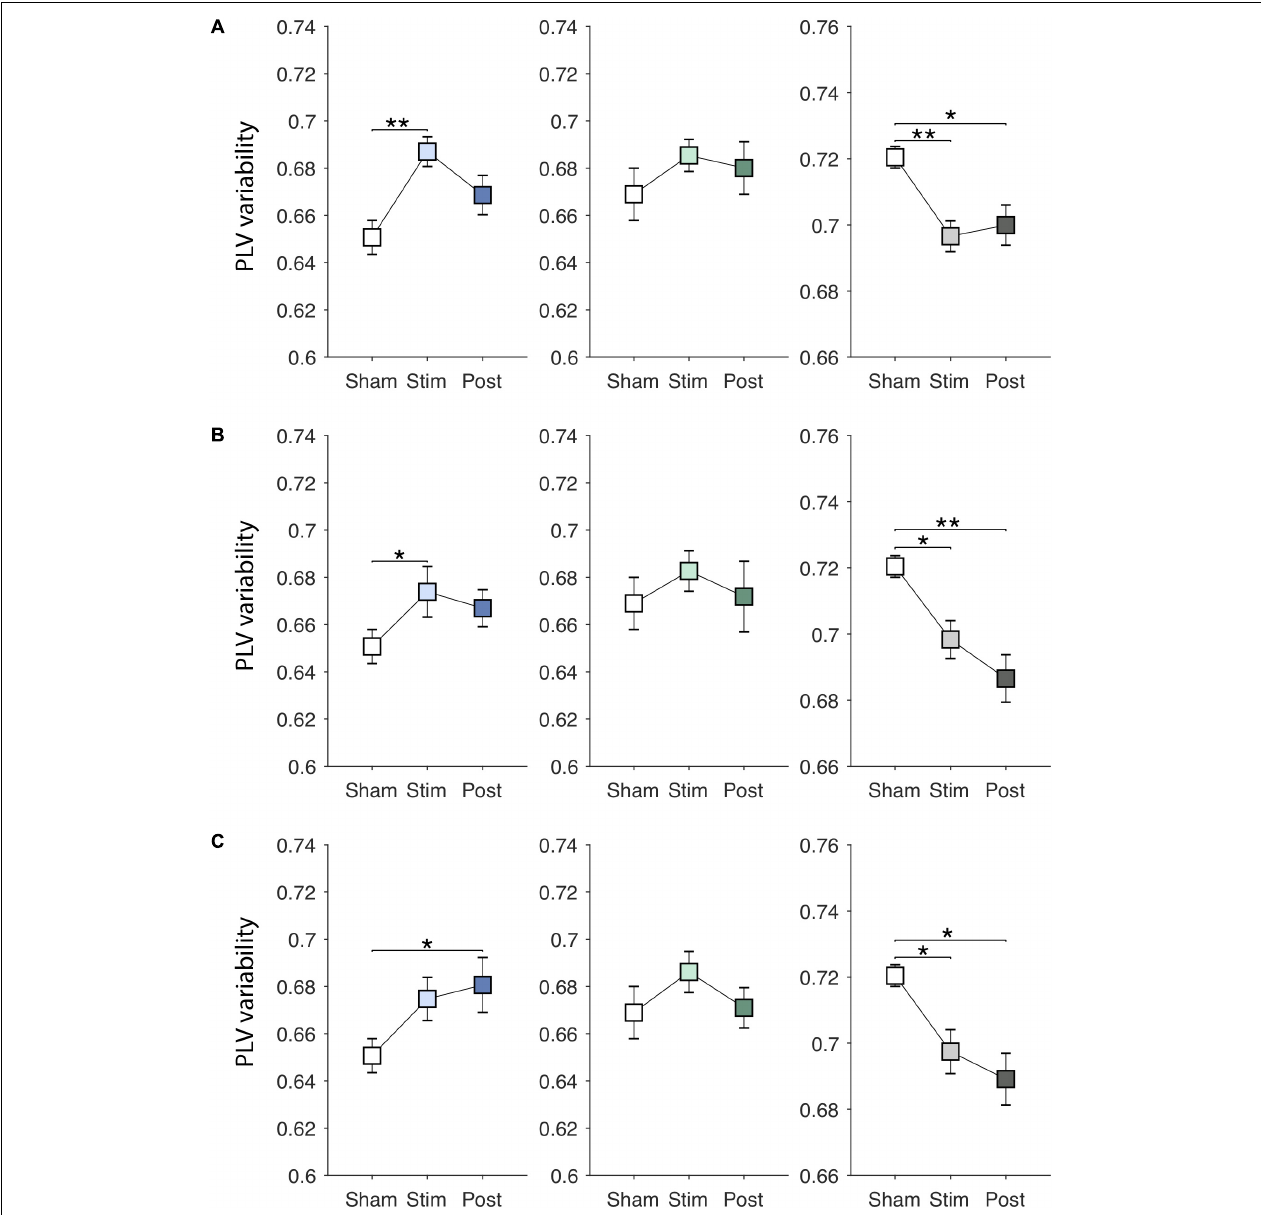
FIGURE 5 | Effects of EVS on the PLV variability. The PLV variability values in the sham condition are identical to those in Figure 3A . Descriptions for the arrangement of the plots and statistical significance are same as in the Figure 4 . (A) EVS1 effects. (B) EVS2 effects. (C) EVS3